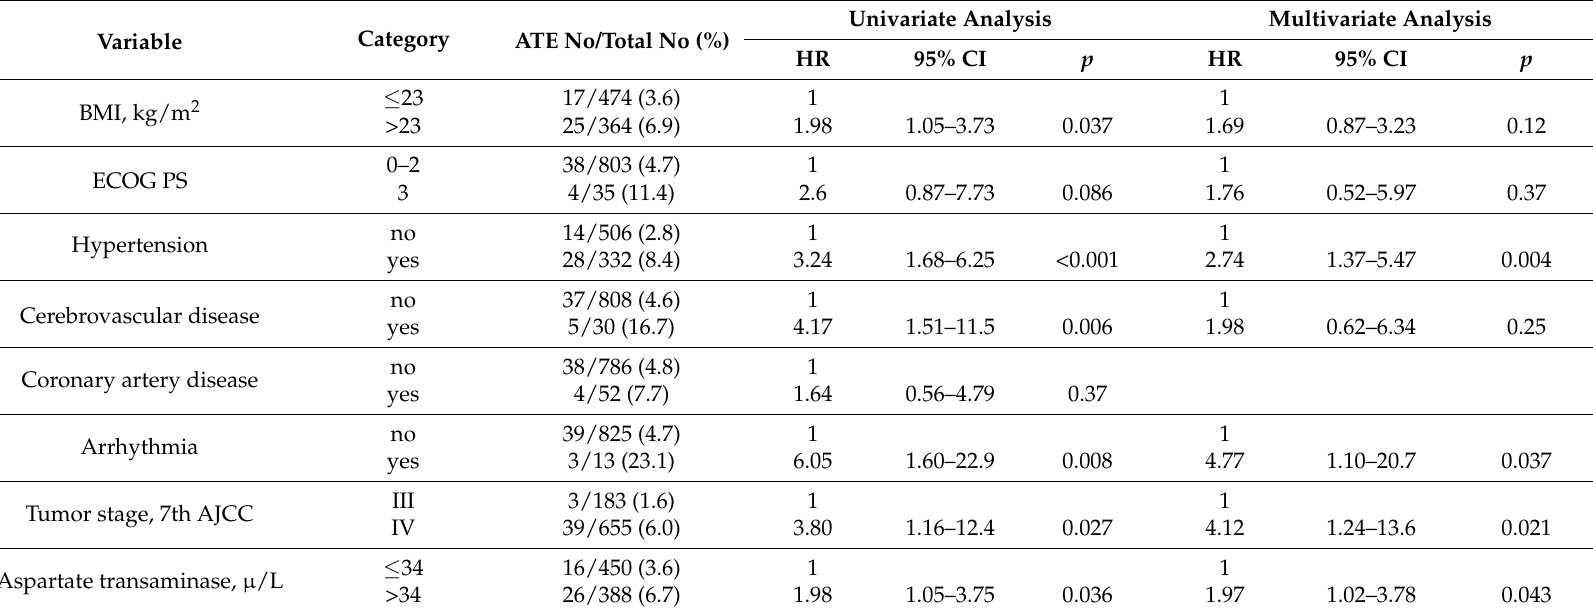
Table 2. Univariate and multivariate analysis for prediction of